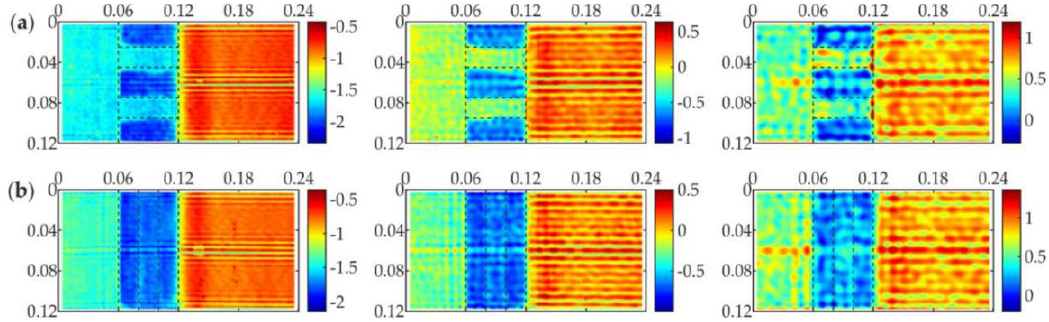
Figure 12. WRMS maps (values in (m/s)) with linear weighting factor ( w r = r ), time window T = 3.00 ms and with different excitation frequencies f = 200 kHz (first column), f = 100 kHz (second column), f = 50 kHz (third column): ( a ) specimen #6; and ( b ) specimen #7.